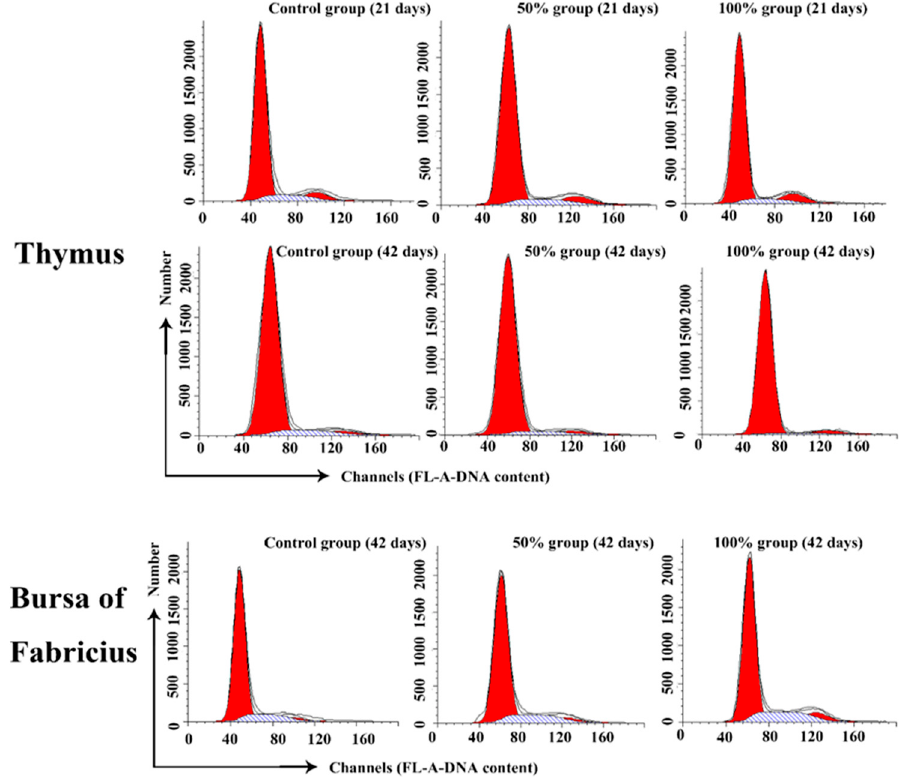
Figure 5. Histogram of cell cycle by FCM. In the thymus, the increase of G2M phase cells at 21 days of age and the decrease of S and G2M phase cells in AFB-contaminated groups at 42 days of age are obviously seen. In the BF, the increase of S and G2M phase cells can be observed.